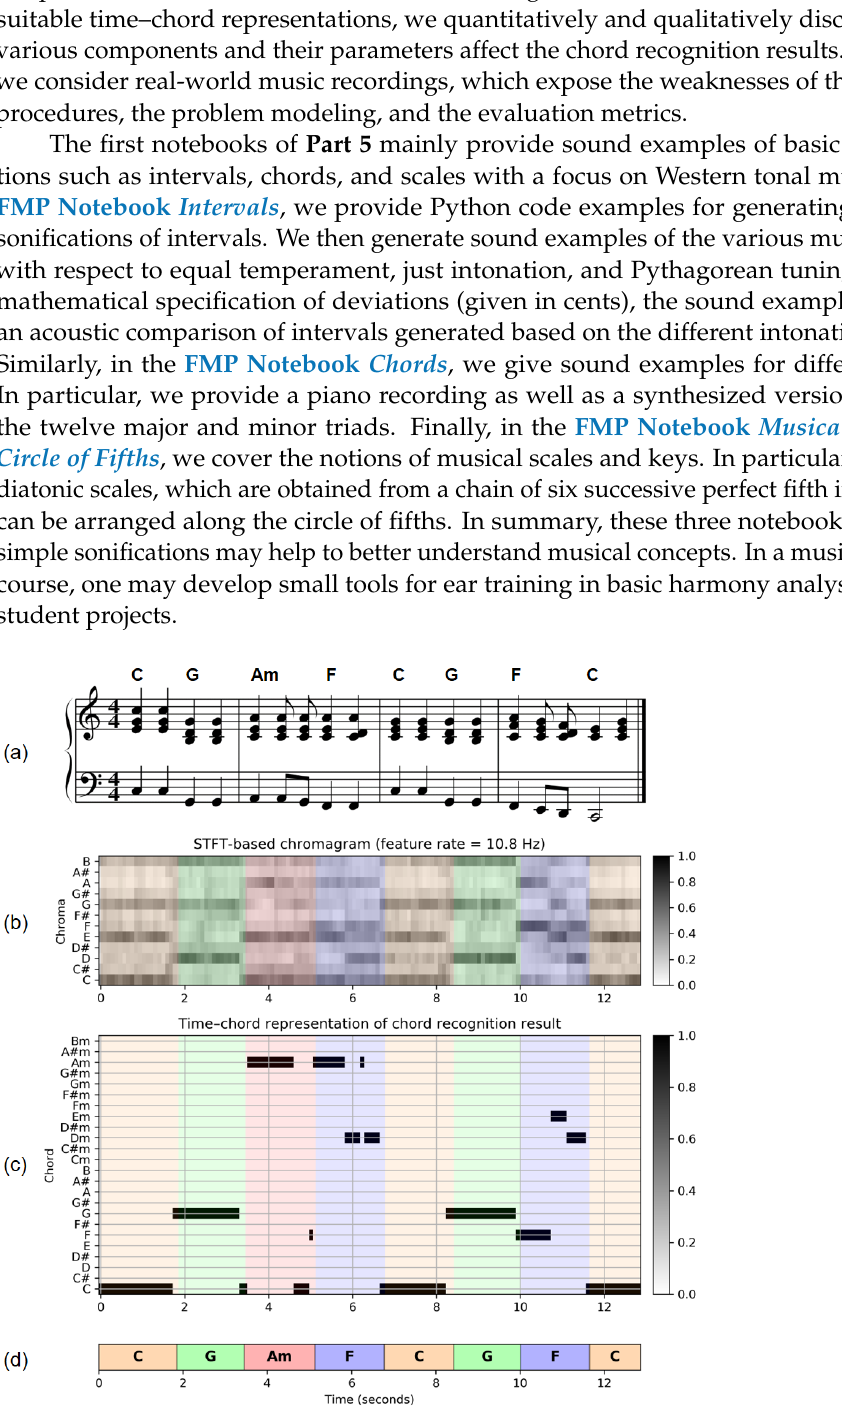
Figure 13. Chord recognition task illustrated by the first measures of the Beatles song “Let It Be.” ( a ) Score of the first four measures. ( b ) Chromagram (visually superimposed with a reference annotation) derived from an audio recording. ( c ) Chord recognition result shown as binary time– chord representation (visually superimposed with a reference annotation). ( d ) Reference